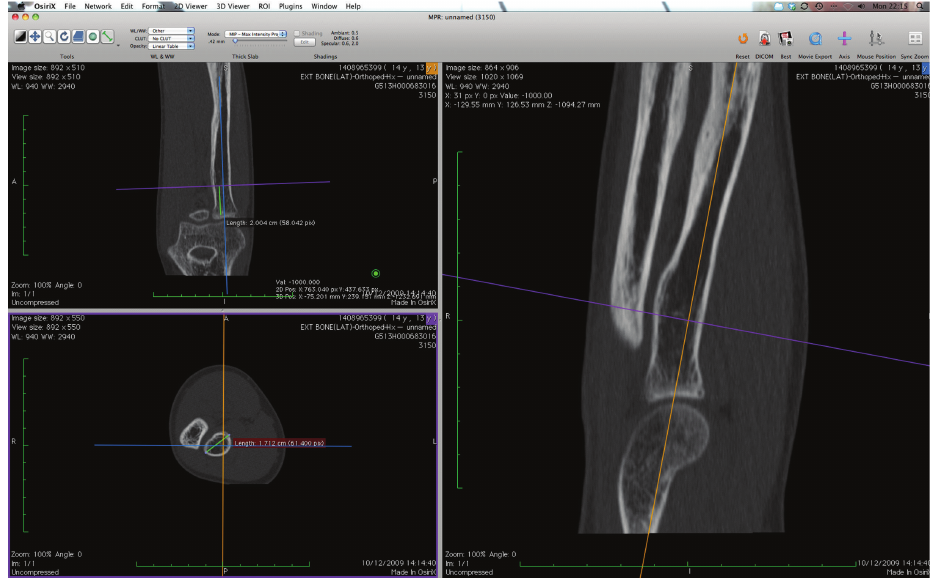
Figure 8: Measurements on CT